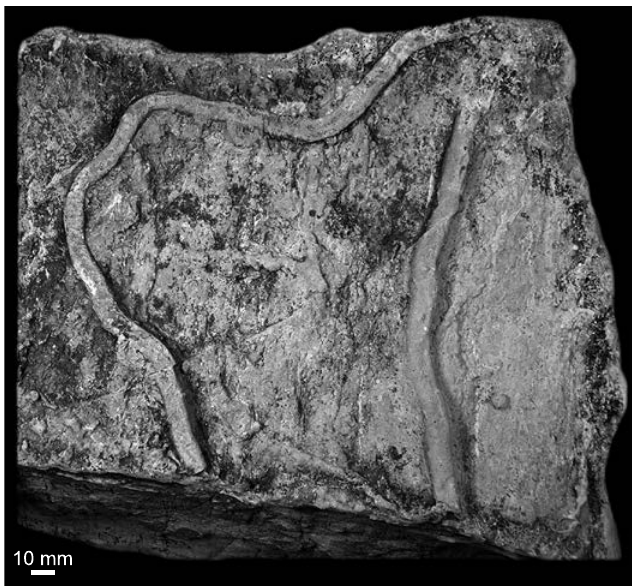
Fig. 3. Simple horizontal trail Helminthopsis tenuis Książkiewicz, 1968, MZM Ge 32946, from Velká nad Veličkou, Czech Republic,